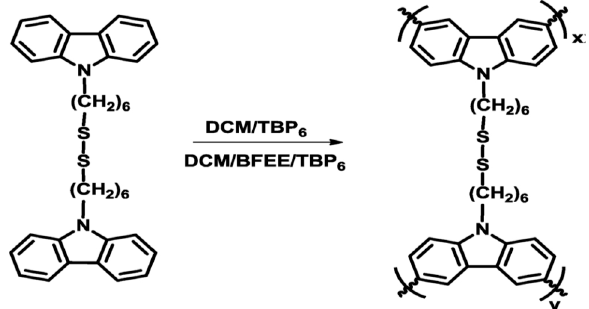
Figure 15. Electrochemical polymerization of 1,2-bis[6-(9-carbozol-9-yl)hexyl]disulfane proposed by Soganci et al. Reproduced with permission from [48]. Copyright (2018) Elsevier.